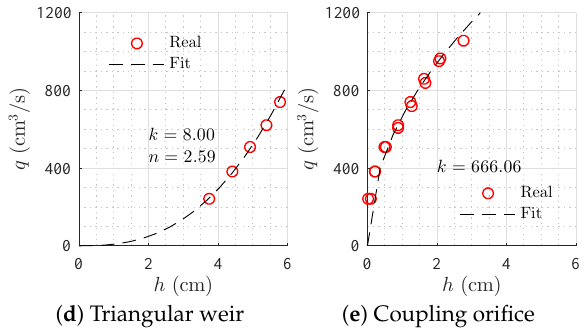
Figure 5. Weirs’ parameters approximation.